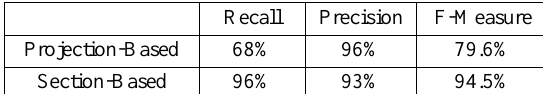
Figure 17. Smoothed edges